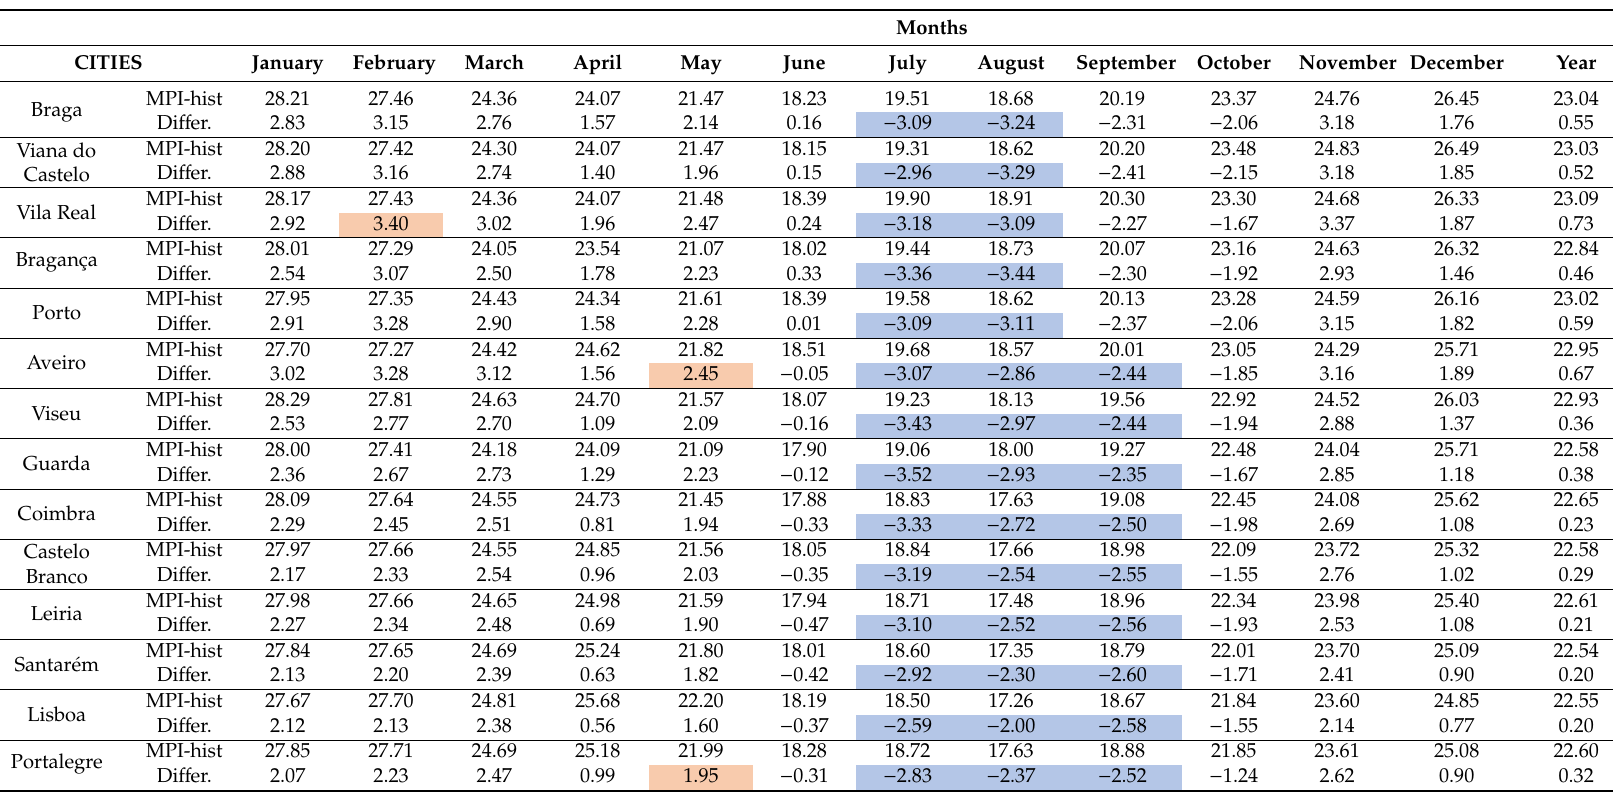
Table 7. Monthly and annual averaged wind speed at 300 hPa for each city and the di ff erence between the future and the historical climates. Significant di ff erences ( t -student 5%) are shown in red (positive) and blue